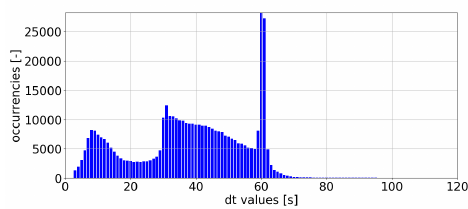
Figure 8. Histogram of ∆ t in the case of line 11 after the outlier removal.